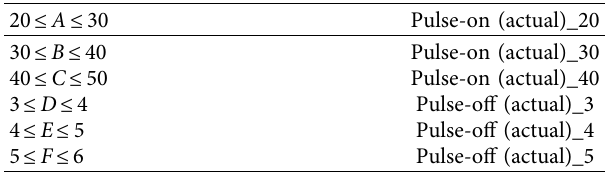
Table 22: Boundary conditions used to run the algorithm.